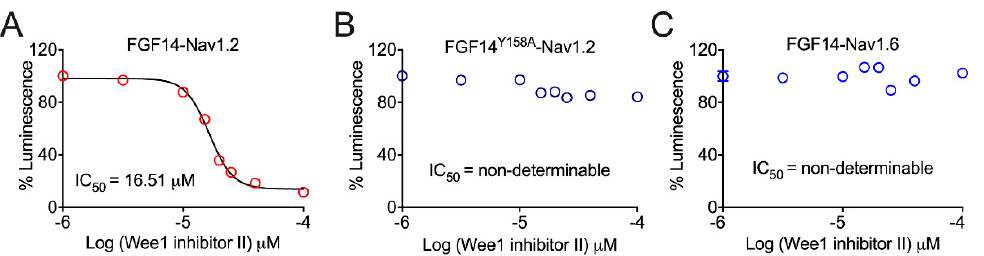
Figure 1. Evaluation of the effects of Wee1 inhibitor II on FGF14:Na v 1.2 and FGF14:Na v 1.6 complex assembly. ( A ) Percentage luminescence (normalized to per plate control wells treated with 0.5% DMSO; n = 32 wells per plate) plotted as a function of log concentration of Wee1 inhibitor II to characterize dose-dependent effects of pharmacological inhibition of Wee1 kinase on FGF14:Na v 1.2 complex assembly (range of concentrations tested = 1 µM–150 µm; n = 6 wells per concentration). ( B ) Effects of different concentrations (range = 1 µM–150 µM; n = 6 wells per concentration) of Wee1 inhibitor II on FGF14 Y158A :Na v 1.2 complex assembly. ( C ) Effects of different concentrations of Wee1 inhibitor II (range = 1 µM–150 µM; n = 6 wells per concentration) on FGF14:Na v 1.6 complex assembly. Data are represented as mean ± SEM.